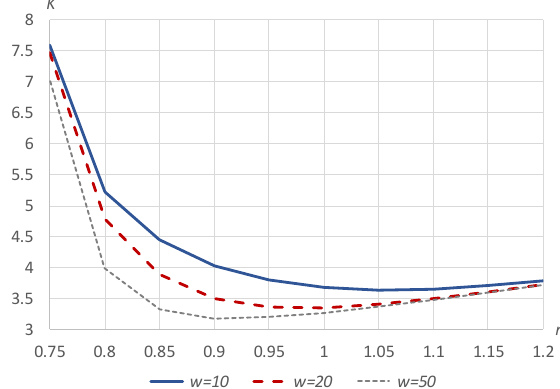
Figure 1. Values of the total cost K ( m ) for various values of bound w